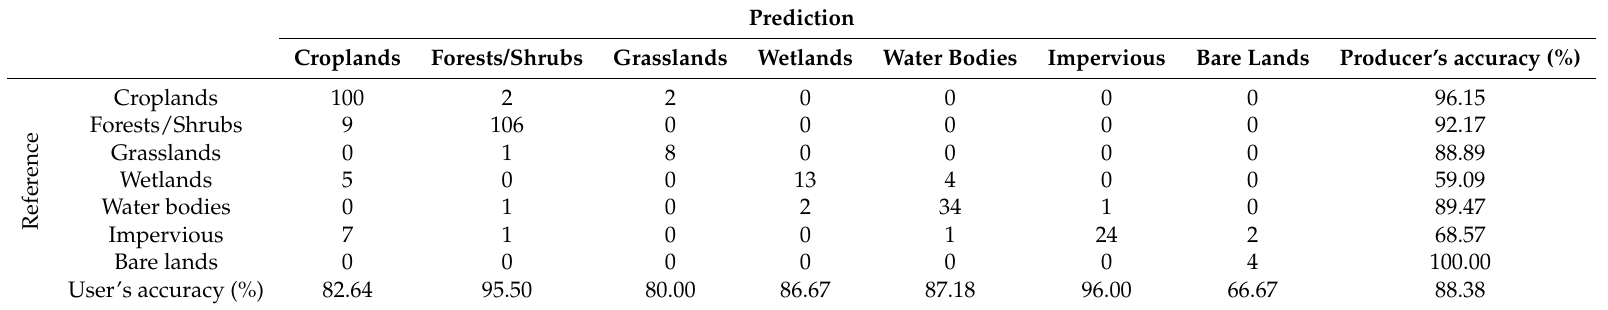
Table 3. Confusion matrix for the integrated land cover map of